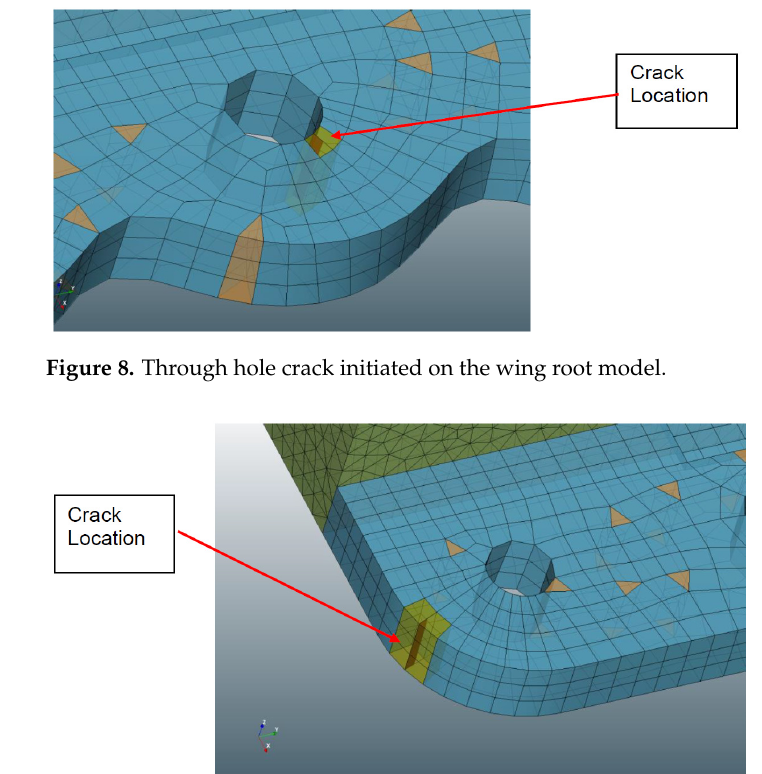
Figure 9. Through side (edge) crack initiated on the wing root model.